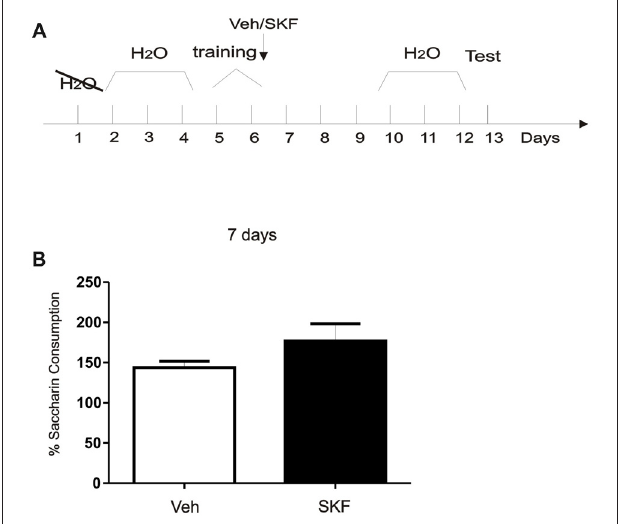
FIGURE 5 | Activation of mPFC D1/5R after exposure of a neutral, context-independent paradigm did not generate an aversive response. (A) Schema of the modified conditioned taste aversion (CTA) protocol used. (B) Animals were infused with D1R agonist SKF 38393 in the mPFC immediately after being trained on saccharin consumption. Test was performed 7 days later. No significant differences were found between groups ( p > 0.05, n =